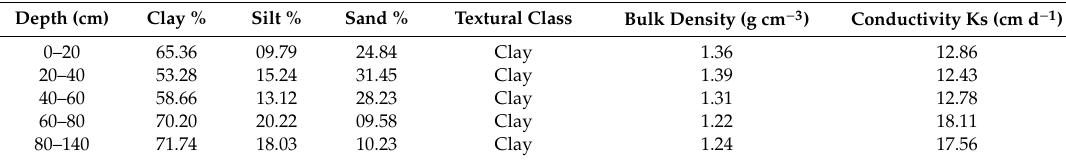
Table 1. Physical properties of the soil in the experimental field at Malaysian Agricultural Research and Development Institute (MARDI).